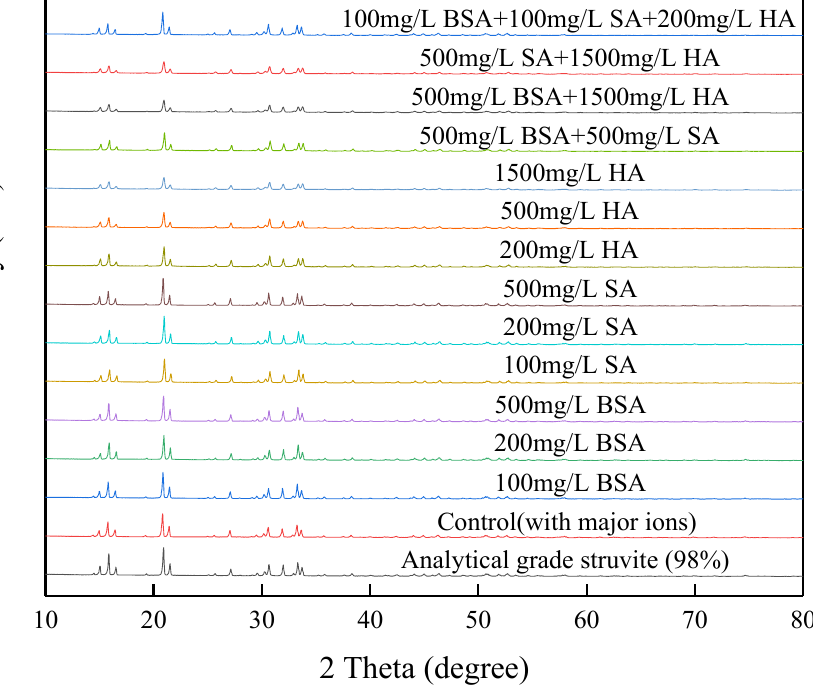
Figure 9. XRD diffractogram of precipitates.